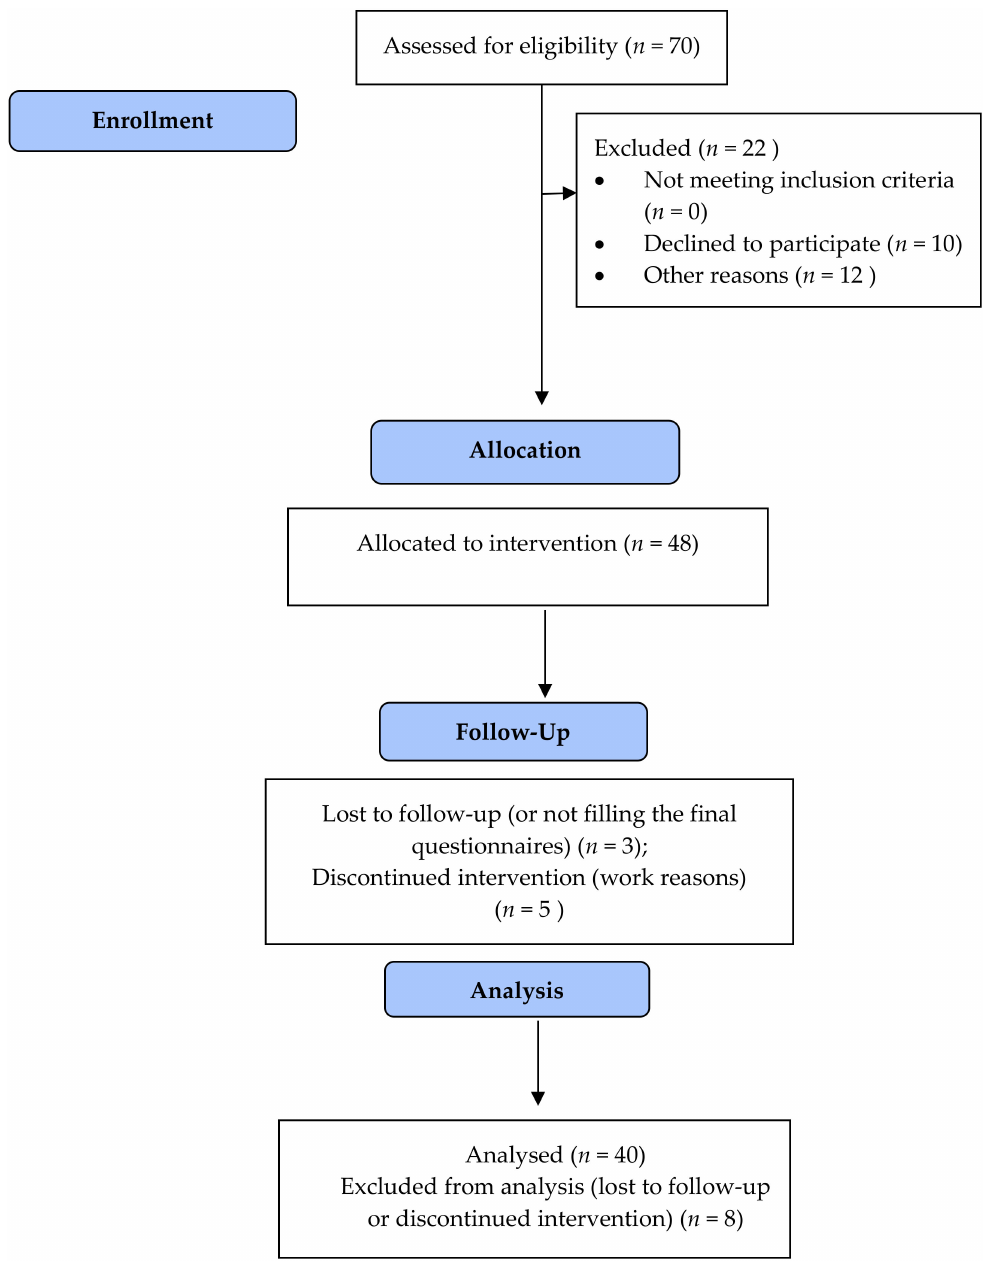
Figure 1. Flow Diagram of the